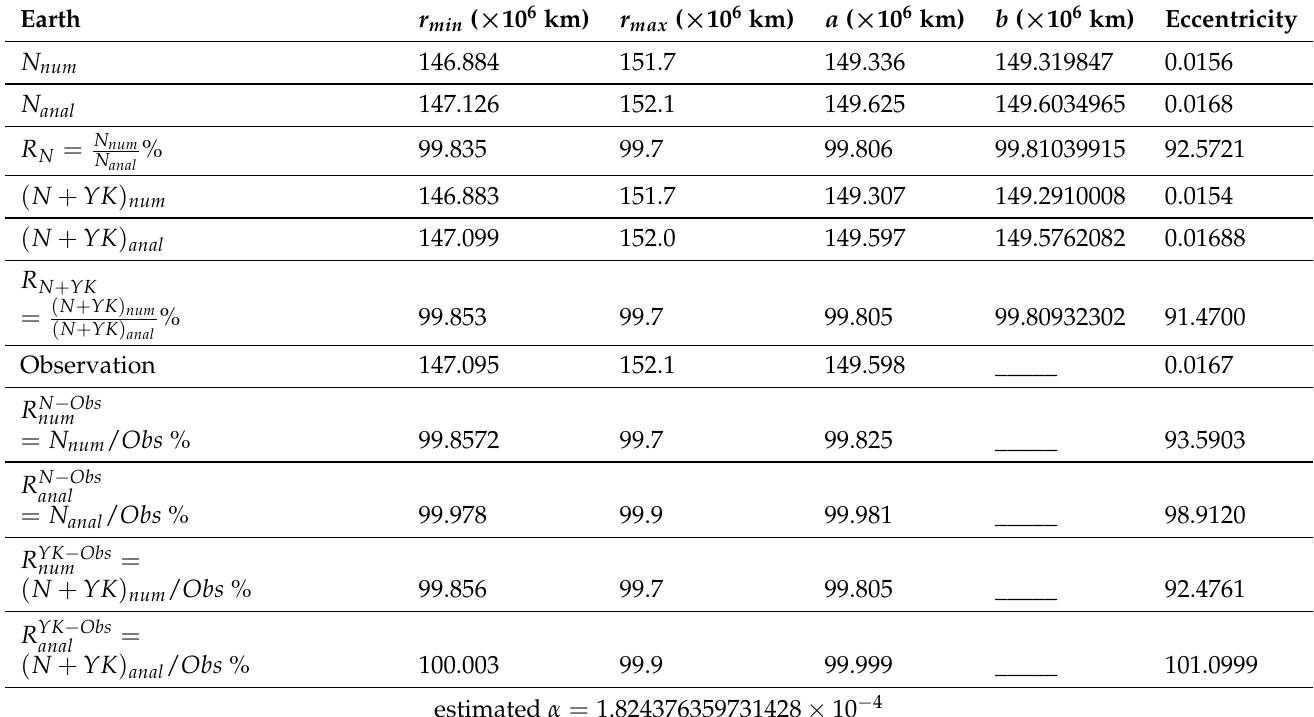
Table A6. The values of the calculated and observational astronomical parameters, for estimated α , of the planet Earth, whose number of moons is 0.